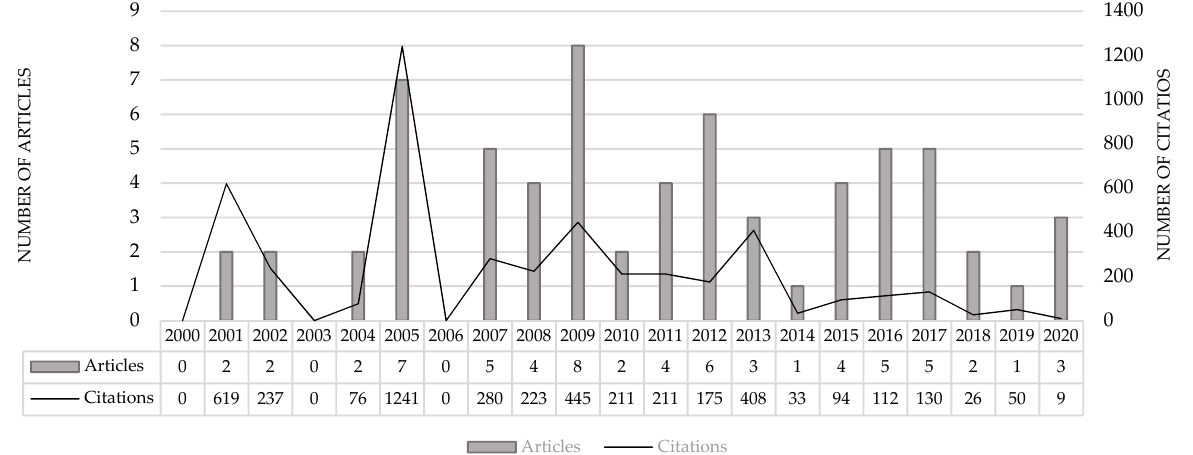
Figure 4. Evolution of the number of publications and citations.